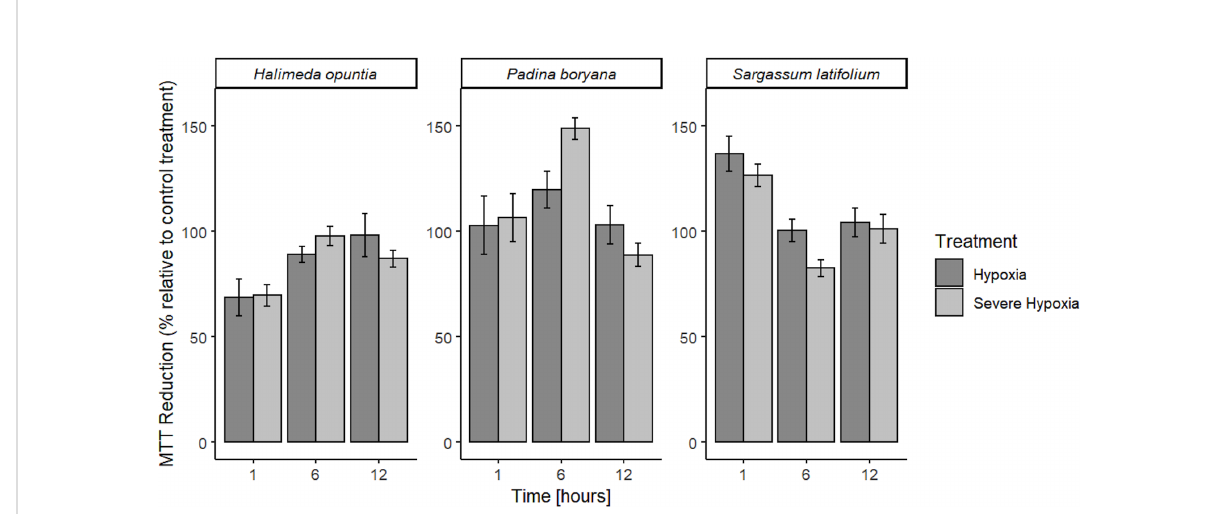
FIGURE 2 Mean % MTT reduction capacity in low DO treatments (OD gDW -1 ) relative to control treatment ± SE (n=3) for Halimeda opuntia , Padina boryana , and Sargassum latifolium . No lethal results were detected, all tissue fragments were viable throughout the experimental duration (12h) and had suf fi cient MTT reduction